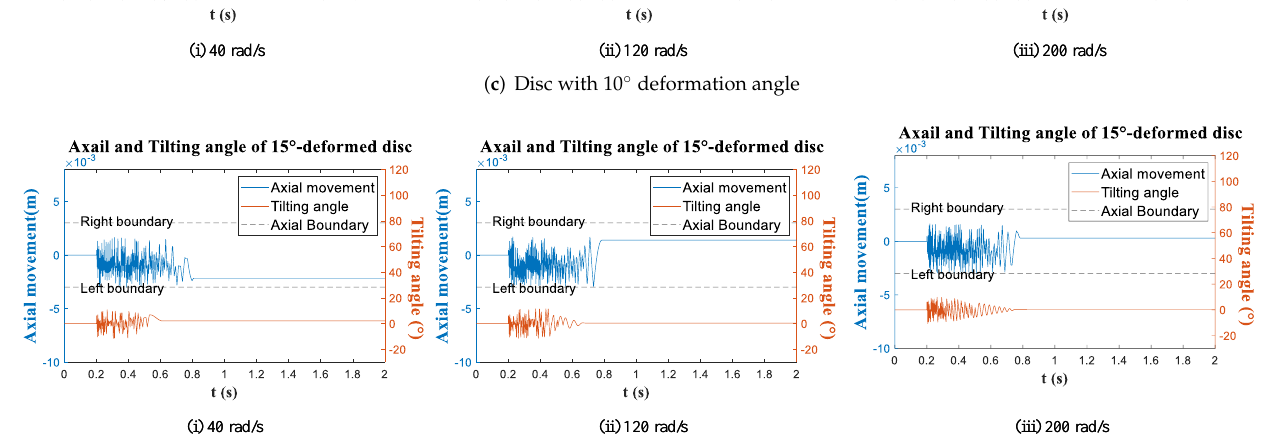
Figure 11. Time response: BC = 6 mm, initial force = 5